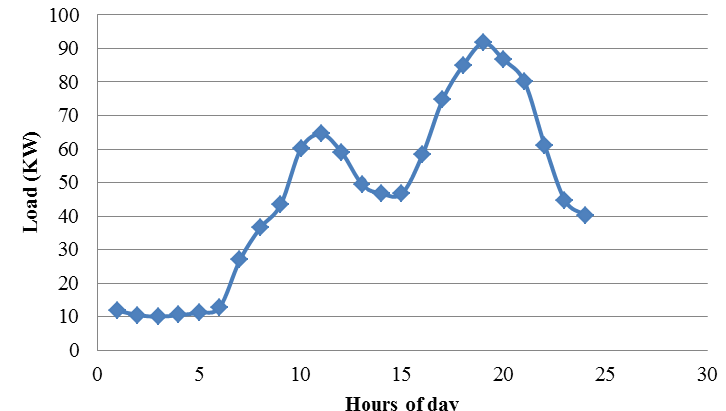
Figure 4. Profile of electrical load of the residential